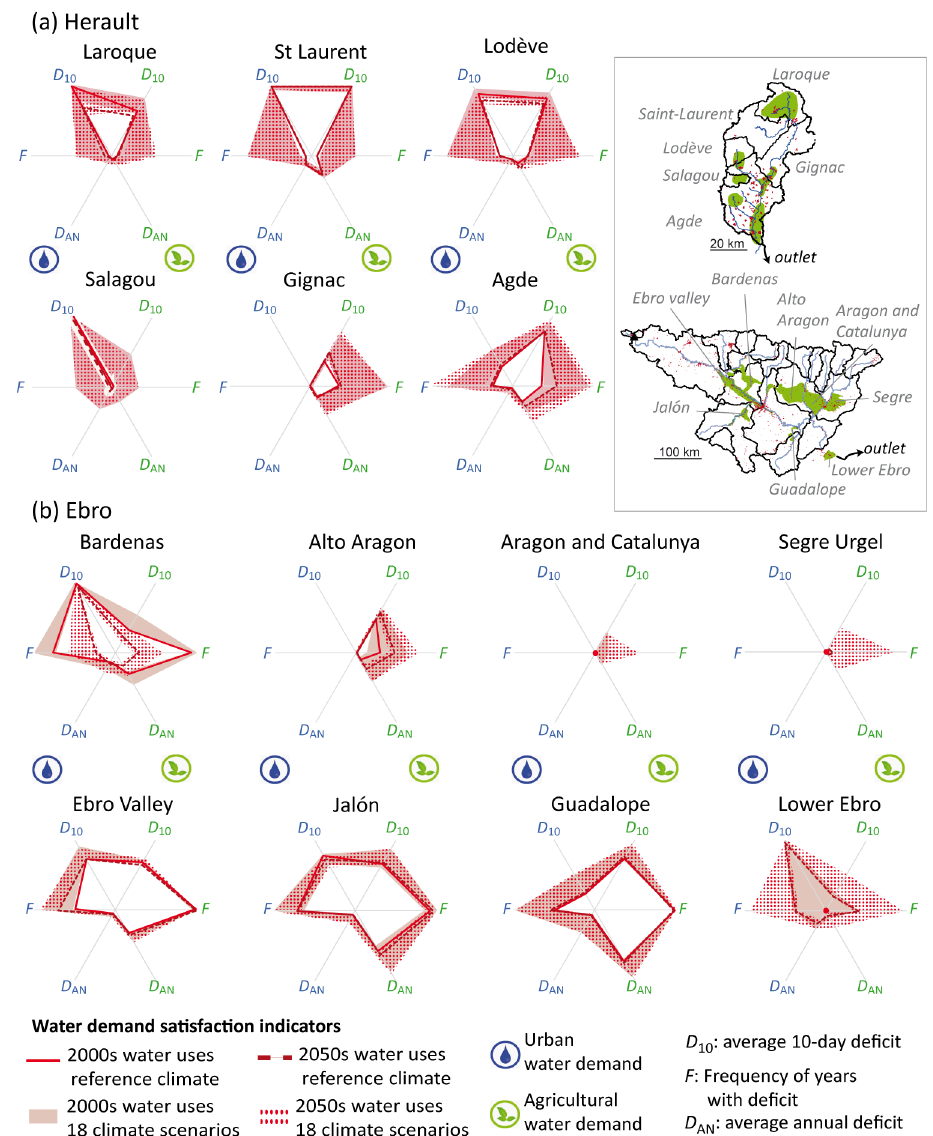
Figure 5. Water demand satisfaction indicators for urban and agricultural water demands in (a) the Herault basin and (b) the Ebro basin under four combinations of water use and climate scenarios. Each radar chart presents the results for one demand node. For all three indicators values range from 0 (no deficit) to 1 (maximum frequency or intensity of